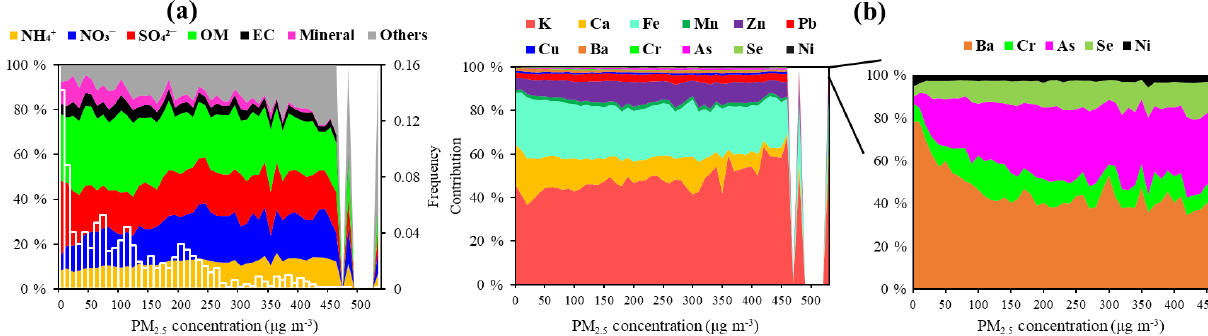
Figure 1. Chemical composition of PM 2 . 5 during sampling period (red for SO 2 − EC, pink for mineral and grey for others). Dates are mm/dd and are from 7 November to 22 December.